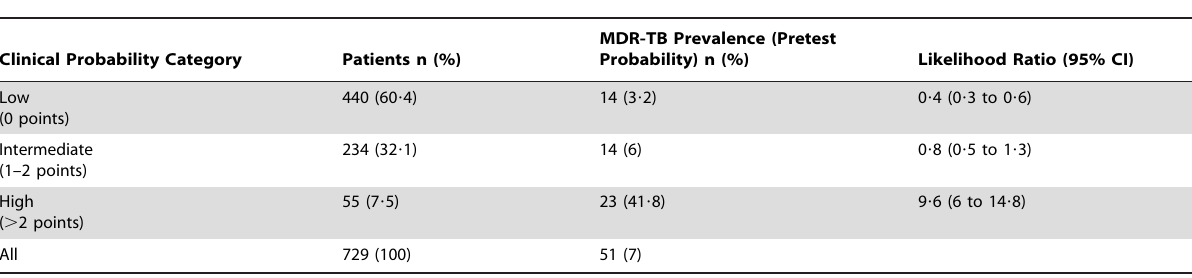
Table 3. Proportion of Patients Classified by the MDR-TB Score and Likelihood